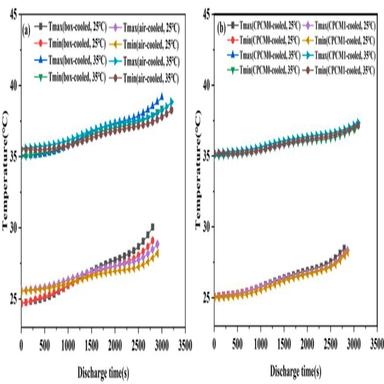
The variation of battery temperature at different ambient temperature at discharge rate of 0.5C: temperature rise under box and air cooled (b) temperature rise under CPCM0 and CPCM1 cooled.